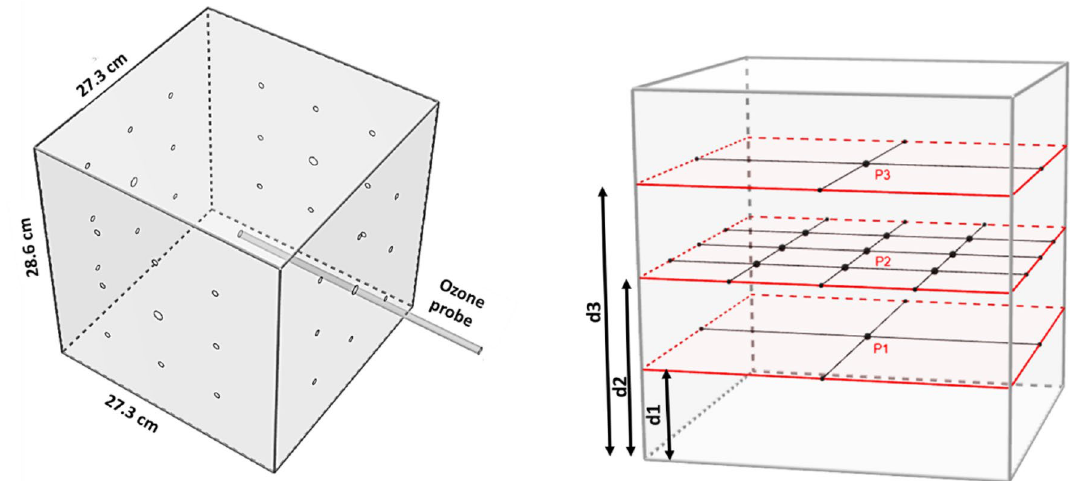
Figure 1. Schematic of APS decontamination box showing drilled holes for accessing decontamination measurement locations in three planes inside the box. This set up also provided access to the center of the box for ozone data collection using a probe connected to a ozone